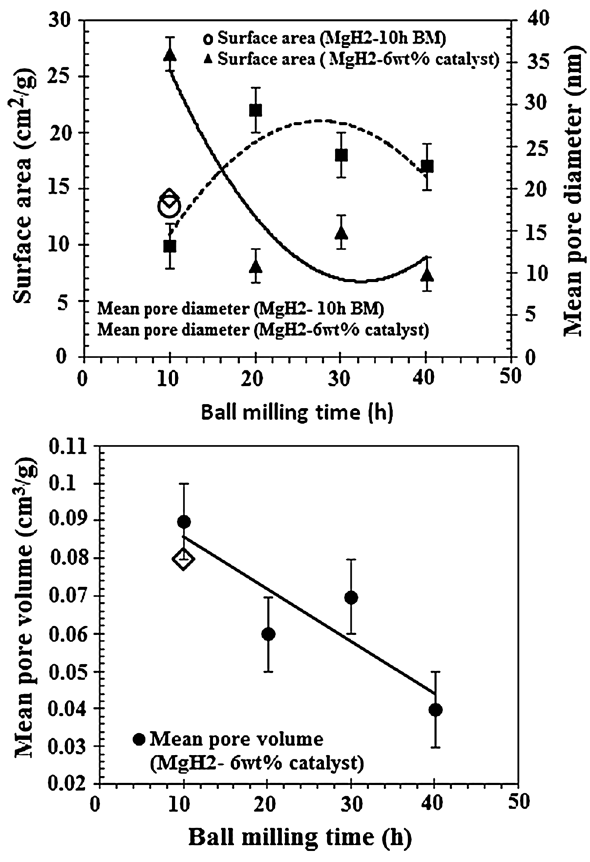
Fig. 9 Free surface, mean porosity diameter, and mean pore volume for the 10 h ball-milled MgH 2 and MgH 2 -6 wt% of mischmetal ball- milled for 10, 20, 30, and 40 h